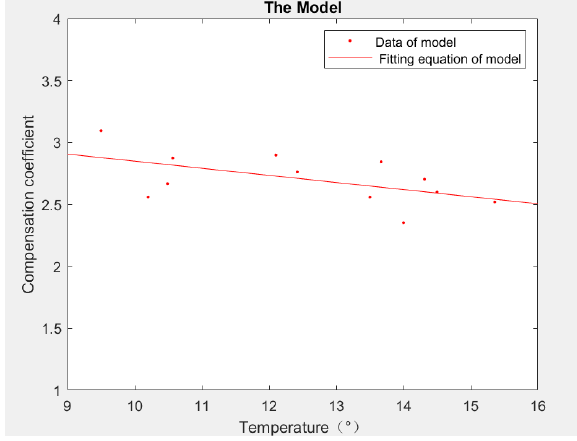
Figure 10. Fitting process of compensation coefficient relationship.